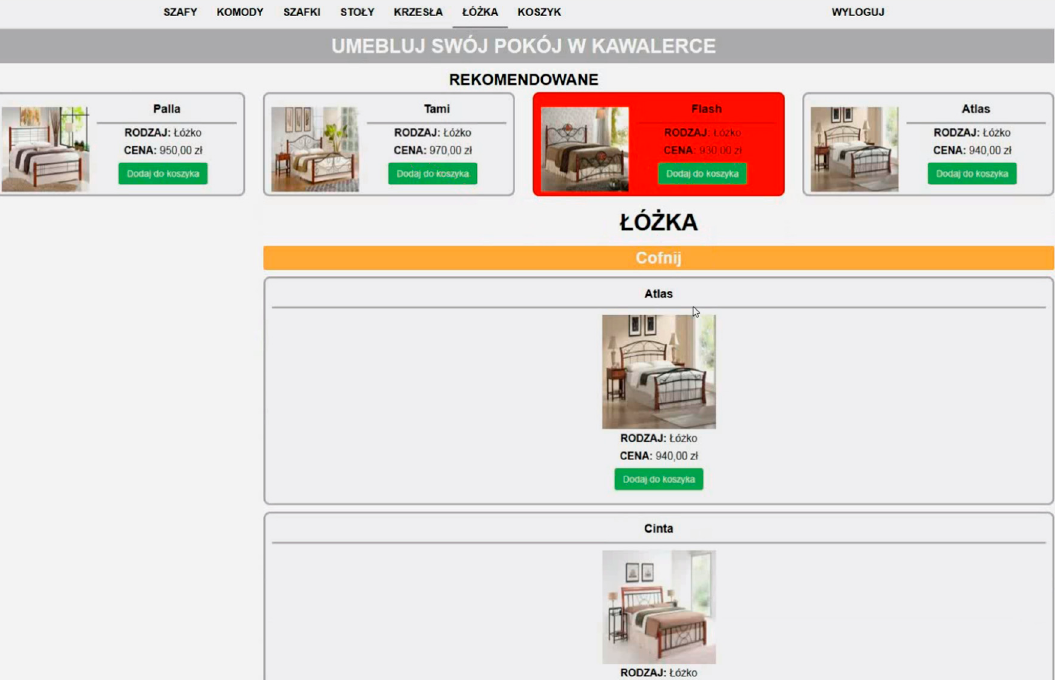
Figure 3. Example of visual intensity VI3 (red background) in the vertical recommending interface.